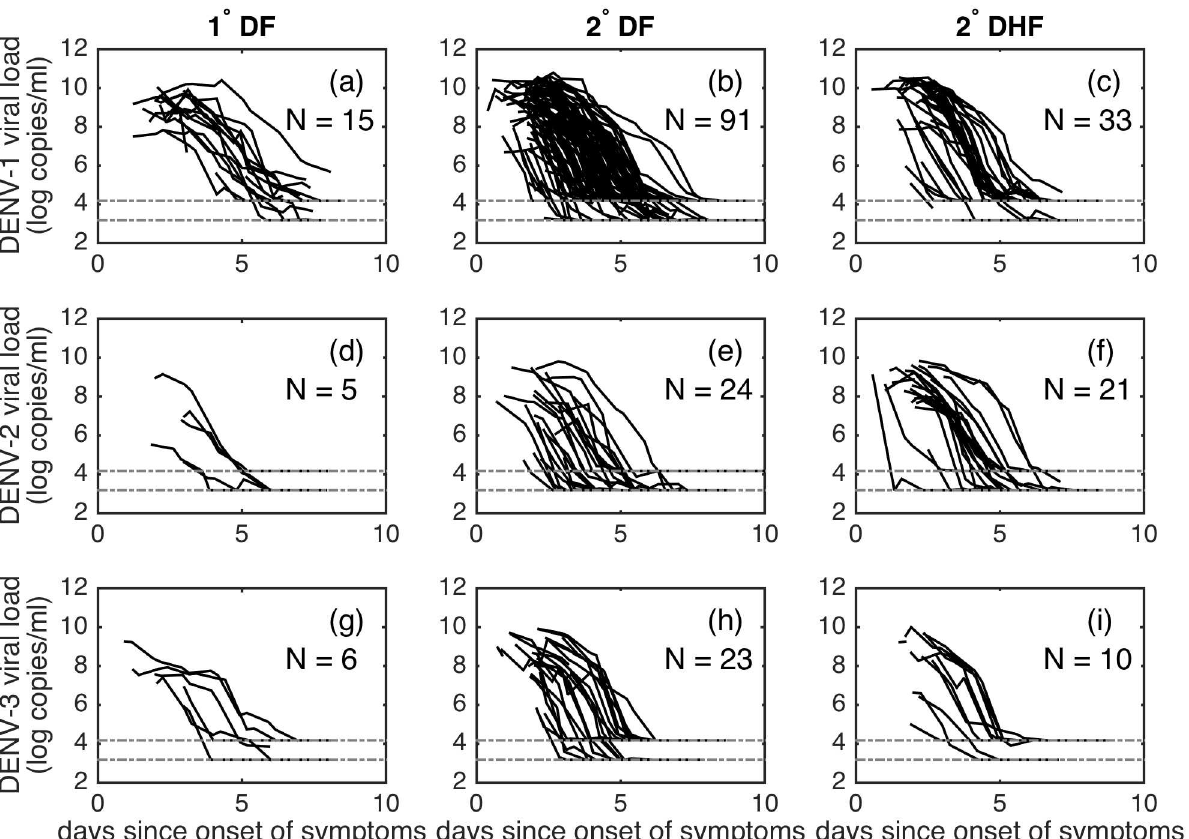
Fig 1. Viral load data. For all subplots, x-axes show time in days since the onset of symptoms and y-axes show viral load in log 10 copies/ ml. Dotted lines show limits of detection for the assays used. Rows correspond to serotypes: (a-c) DENV-1; (d-f) DENV-2; (g-i) DENV-3. Columnscorrespondto immune status and clinical manifestation: (a, d, g): primary infection denguefever; (b, e, h): secondary infection denguefever; (c, f, i): secondary infection denguehemorrhagic fever. The number of patients (N) for whom viral load data are availableis provided in each